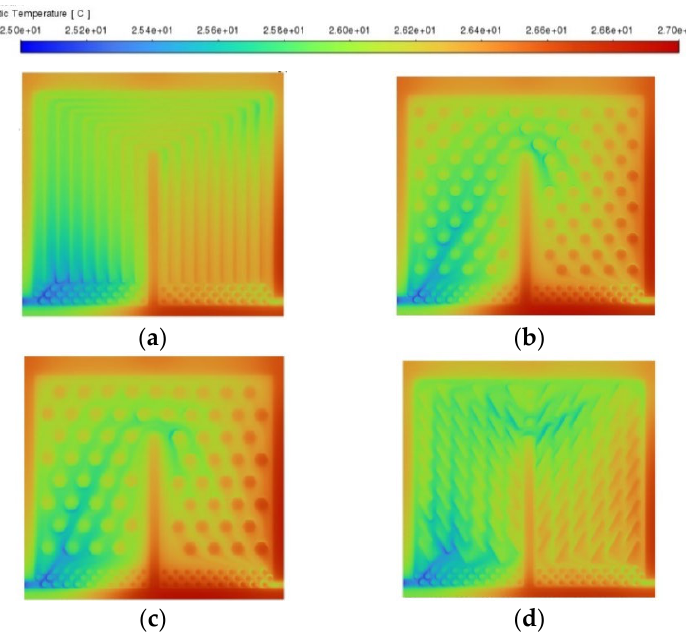
Figure 8. Battery cell surface temperature distribution at 0.4 L/min of flow rate for ( a ) U-shape, ( b ) convex, ( c ) honeycomb, and ( d ) airfoil designs.